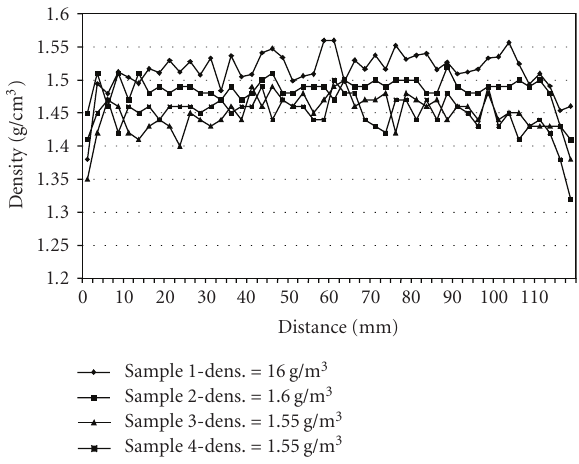
Figure 1: Horizontal variation of soil density in artificially com- pacted soil blocks.